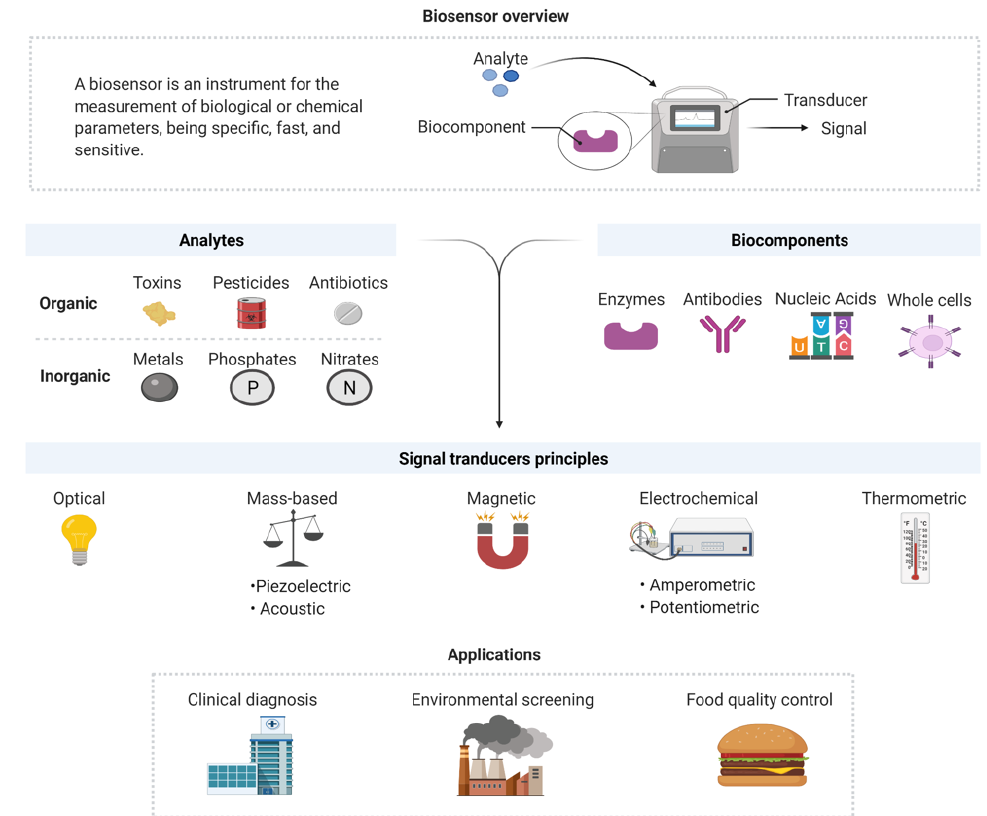
Figure 2. Types of biosensors and their applications.